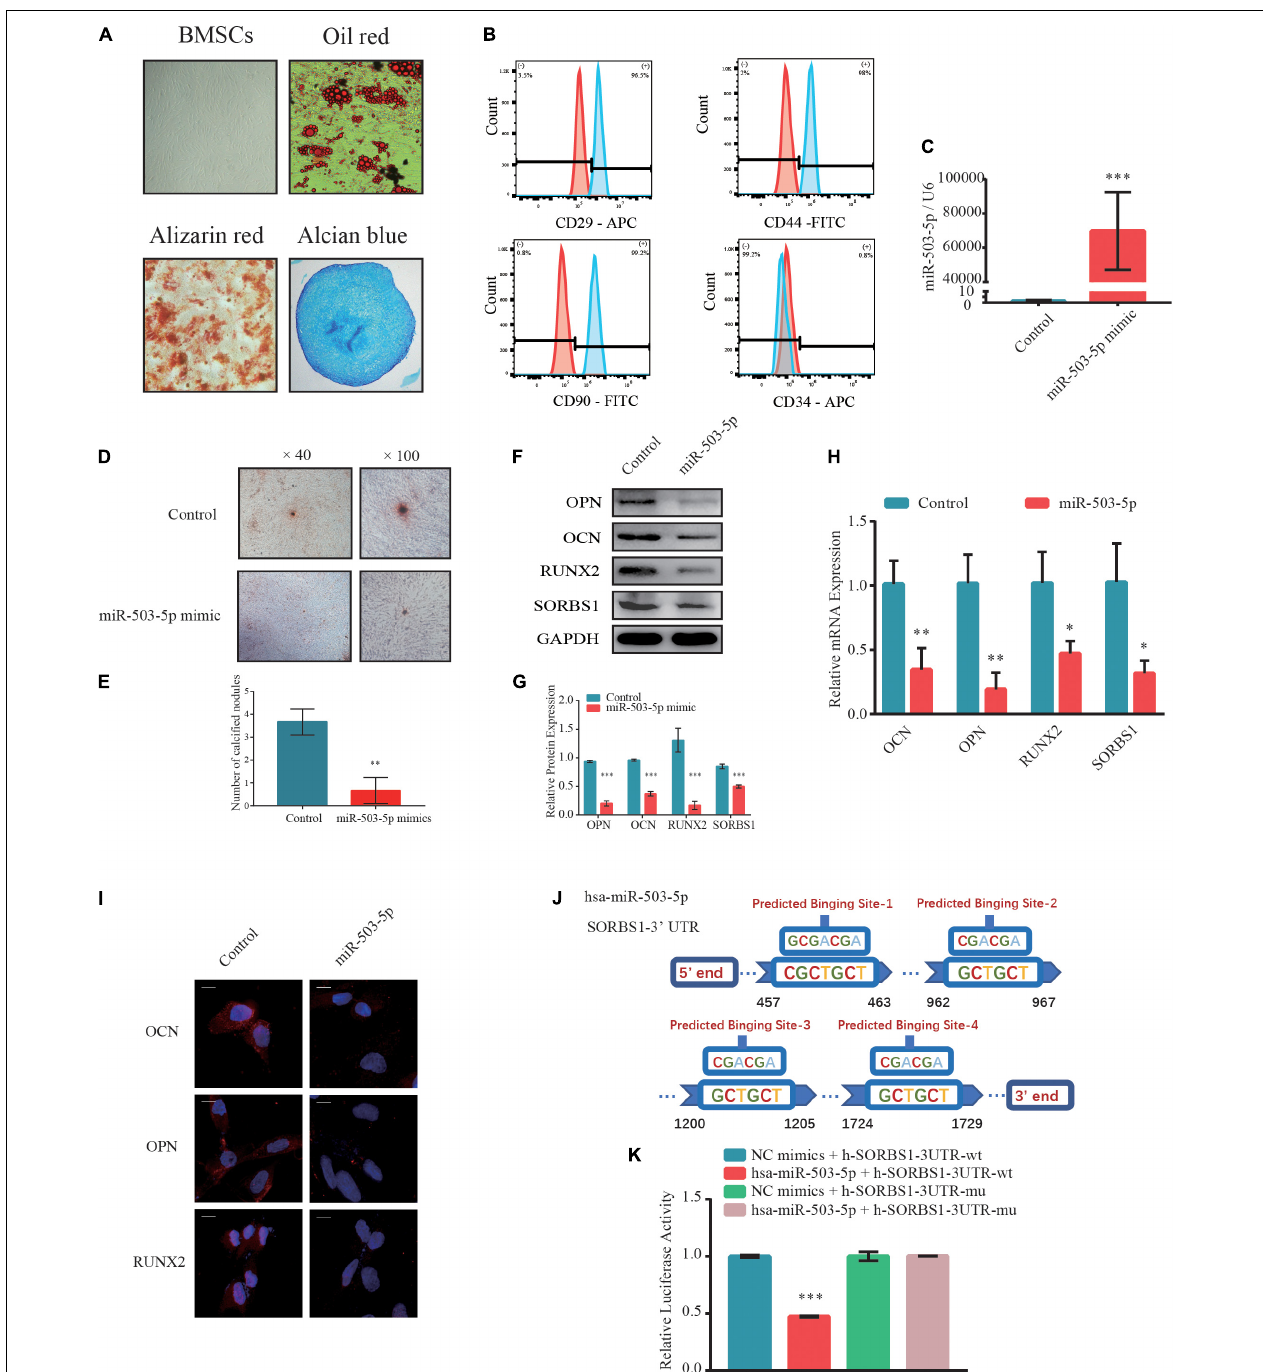
FIGURE 3 | MiR-503-5p/SORBS1 selected to verify the feasibility of the predicted ceRNA network. (A) Adipogenesis, osteogenesis, and chondrogenesis potentials demonstrated by Oil Red O, Alizarin Red, and Alcian Blue staining, respectively. (B) BMSCs identified using flow cytometry. Positive mesenchymal markers included CD29, CD44, and CD90, while the negative mesenchymal marker was CD34. Light blue histograms denote isotype controls. Light red peaks indicate tested markers. (C) MiR-503-5p transfection efficiency as assessed by RT-qPCR. (D) Effects of miR-503-5p on mineralized nodule formation, as demonstrated by Alizarin Red staining and (E) quantitative analysis of mineralized nodules. Expression levels of osteogenesis markers OCN, OPN, and RUNX2 and targeted gene SORBS1 in transfected BMSCs detected using western blotting (F) , quantified protein expression by densitometric analysis (G) , RT-qPCR (H) , and immunofluorescence (I) . (J) Potential binding sites between miR-503-5p and SORBS1-3’ UTR. (K) miR-503-5p binds SORBS1-3’ UTR, as confirmed by luciferase activity assay. GAPDH served as an endogenous control for mRNAs, and U6 acted as an endogenous control for miRNAs. Quantitative data of three independent samples are presented. ∗ p < 0.05, ∗∗ p < 0.01, ∗∗∗ p < 0.001.